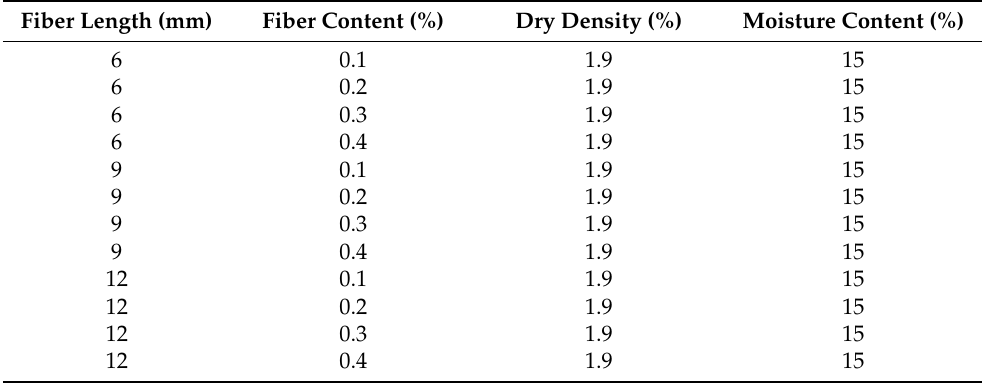
Table 4. Ratio design of the fiber-stabilized shield residues.